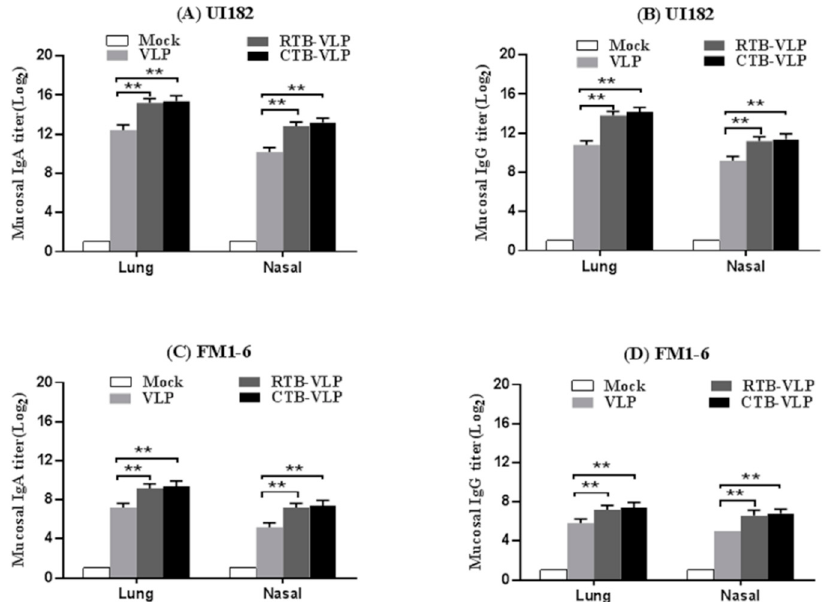
Figure 3. Intranasal immunization with cVLPs enhances mucosal immune responses. ( A , B ) Titers of mucosal secretory IgA ( panel A ) and IgG antibodies ( panel B ) specific for UI182 virus in lung and nasal washes collected from immunized mice 4 days post-challenge with 10 MLD 50 UI182 virus; ( C , D ) Titers of mucosal secretory IgA ( panel C ) and IgG antibodies ( panel D ) specific for FM1-6 virus in lung and nasal washes collected from immunized mice 4 days post-challenge with 10 MLD 50 FM1-6 virus.